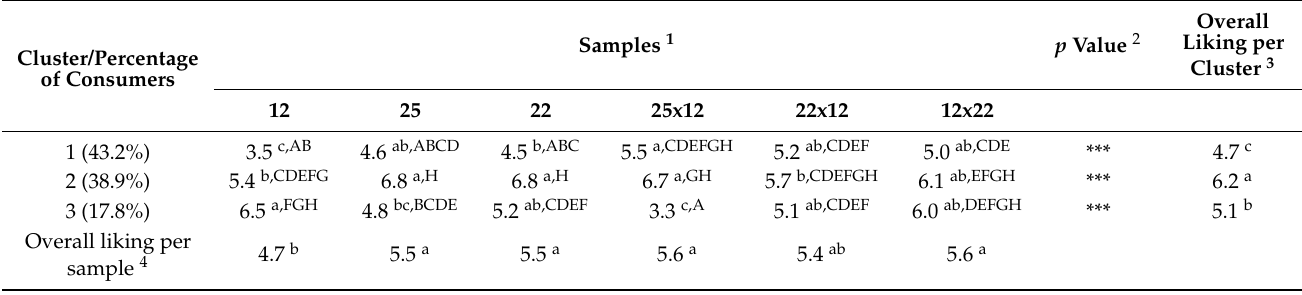
Table 6. Overall liking of the celery samples for the cluster of consumers obtained from agglomerative hierarchical clustering.